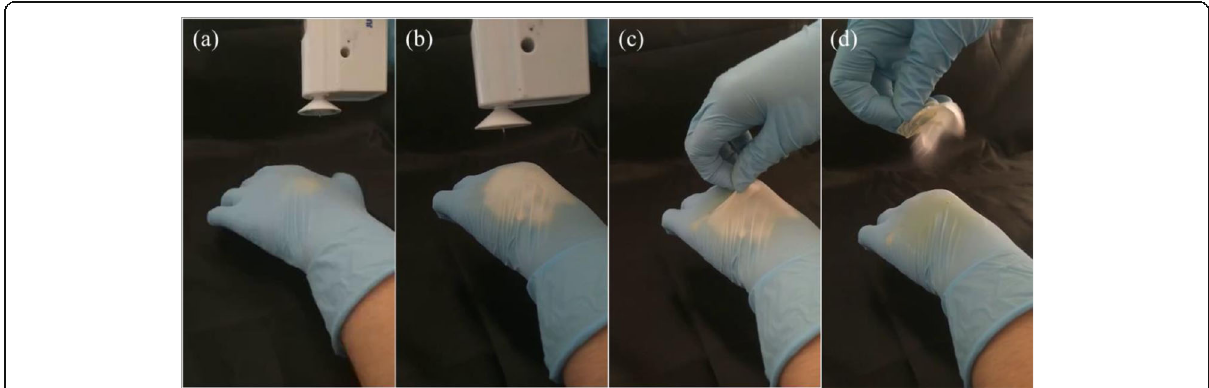
Fig. 7 In situ applications of the handheld apparatus and iodine-based electrospun fibrous mats. By the HHE-1, one can easily in situ electrospun iodine-based PVP/I mesh onto the “ injured hand ” ( a – b ), the electrospun mats can be easily removed from the “ wound bed ” ( c – d